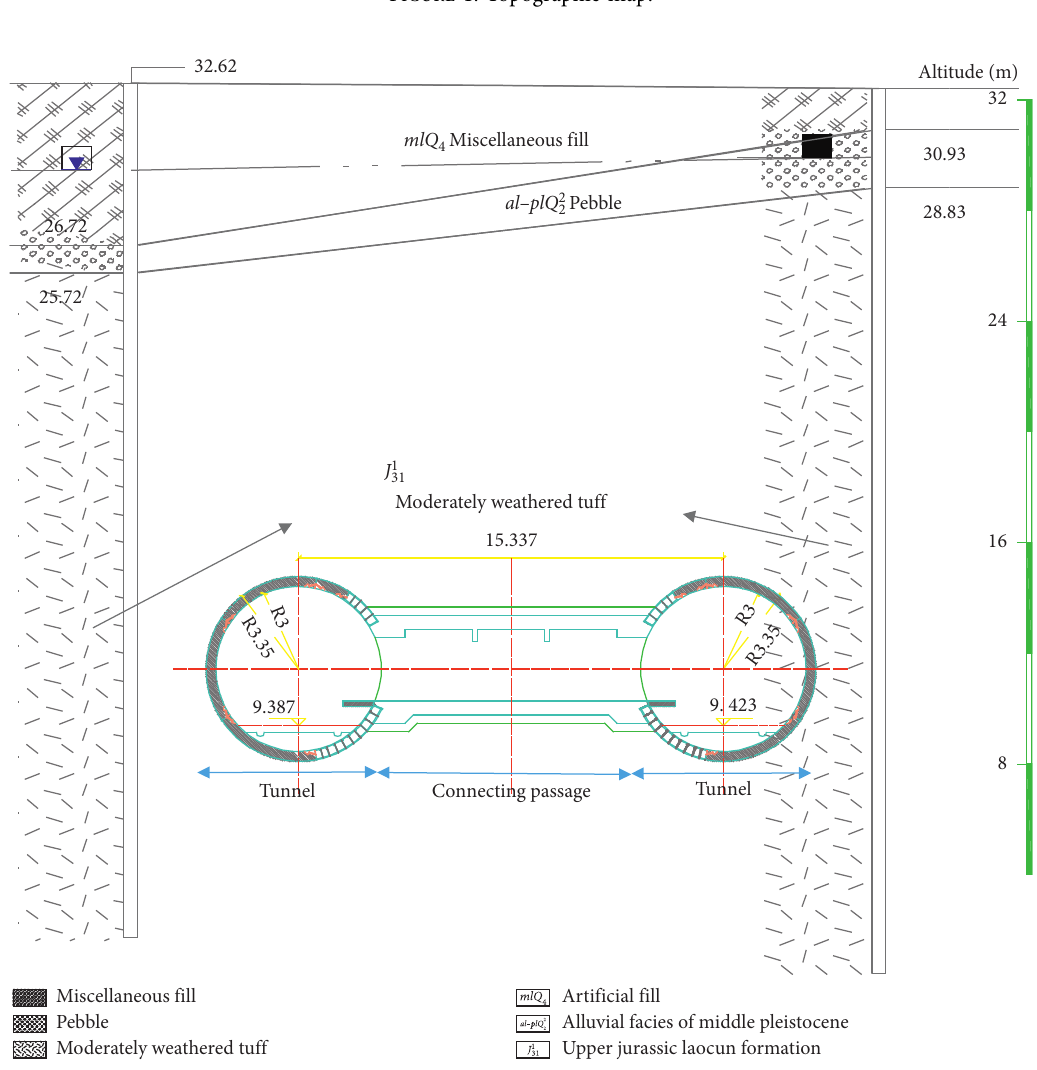
Figure 2: Geological histogram of the surrounding